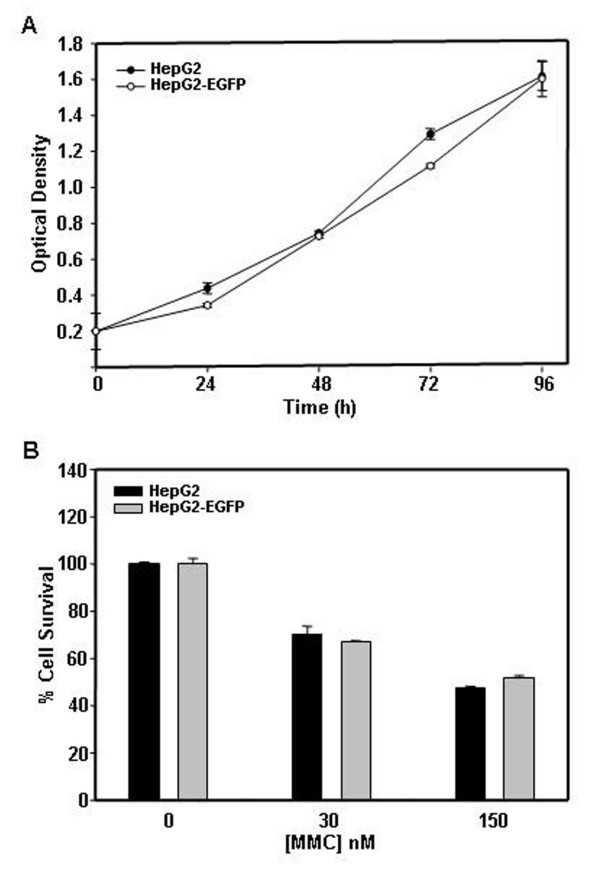
Cell growth and cytotoxicity assay in HepG2 and HepG2-EGFP cell lines. (A) Growth kinetics of HepG2 and HepG2-EGFP cells shows no significant alteration in growth properties. HepG2 and HepG2-EGFP cells (2 × 103) were seeded in a 96 well plate and subsequently cultured for 24 h, 48 h, 72 h and 96 h, and MTT assay was performed. Absorbance was measured at 570 nm using 630 nm as reference filter. Optical density of 0.2 corresponds to 2 × 103 cells. (B) MMC is equally cytotoxic to HepG2 and HepG2-EGFP cells. HepG2 and HepG2-EGFP cells (1 × 104) were seeded in a 96 well plate and kept overnight for adherence. MMC treatment with indicated concentrations was given for 48 h. Cells were grown in a drug free medium for 24 h before performing the MTT assay. Data presented are representative of three independent experiments performed in triplicates and expressed as mean ± s.d.